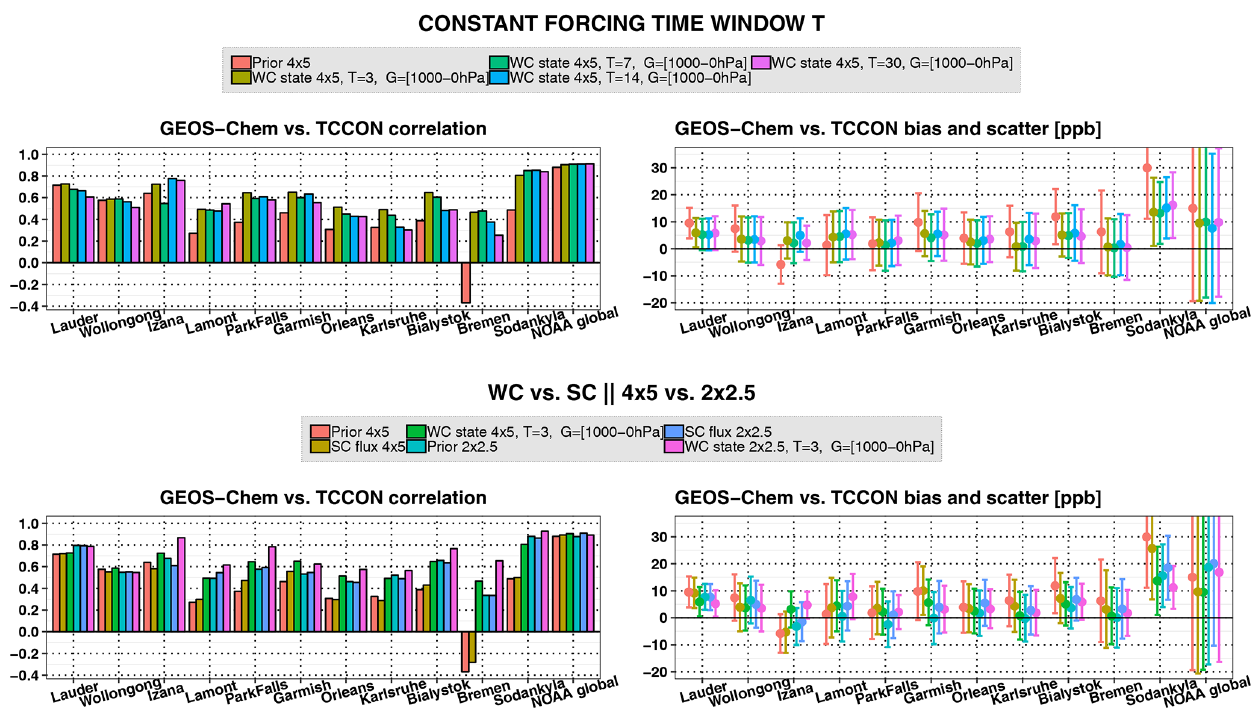
Figure 9. Evaluation of the mean (February–May 2010) a priori and optimized CH 4 fields using TCCON XCH 4 and NOAA surface in situ observations. Results are shown for the four experiments described in Sect. 2.5. For each set of experiments (each row), the left column shows the correlation with respect to the TCCON and NOAA data, whereas the right column shows the mean bias and scatter. Top row: comparison of (red) the a priori fields, (light green) the standard WC assimilation, and the WC assimilation with the forcing terms estimated at altitudes above (dark green) 750hPa, (blue) 500hPa, and (purple) 200hPa. Second row: comparison of (red) the a priori fields, (dark green) the standard WC assimilation, and (blue) the WC assimilation with joint estimation of the state and surface emissions with forcing terms estimated only over North America, Europe, and Asia. Third row: comparison of (red) the a priori fields, (light green) the standard WC assimilation, and the WC assimilation with a constant forcing window of (dark green) 7d, (blue) 14d, and (purple) 30d. Bottom row: comparison of the a priori fields at (red) 4 ◦ × 5 ◦ and (light blue) 2 ◦ × 2.5 ◦ , the SC assimilation at (light green) 4 ◦ × 5 ◦ and (dark blue) 2 ◦ × 2.5 ◦ , and the WC assimilation at (dark green) 4 ◦ × 5 ◦ and (purple) 2 ◦ × 2.5 ◦